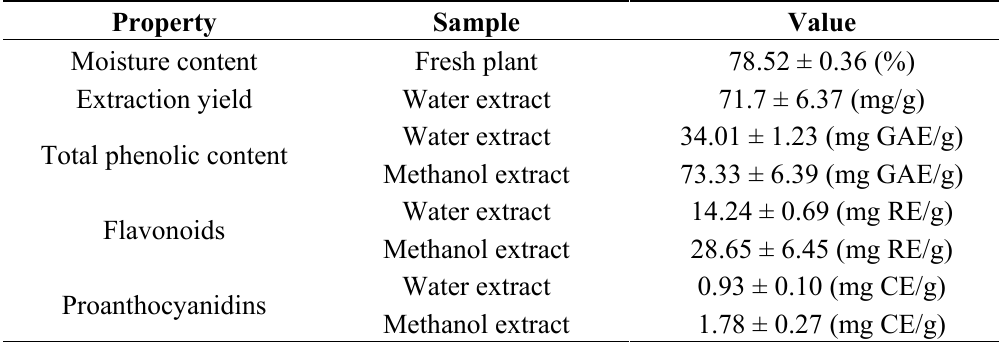
Table 4. Phytochemical properties of E. tirucalli